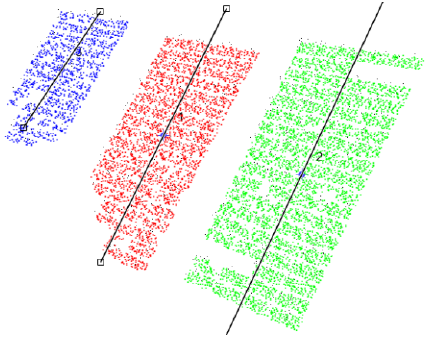
Figure 8. Principal component associated to each module (situation in which there is not a fault in the trackers). Table 1. Module orientation and DI (situation in which there is not a fault in the trackers).